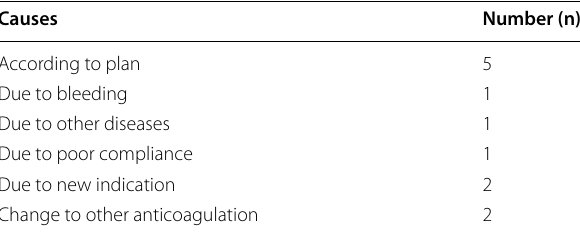
Table 1 Demographics, severity of congenital heart disease (CHD), comorbidities and results of CHA